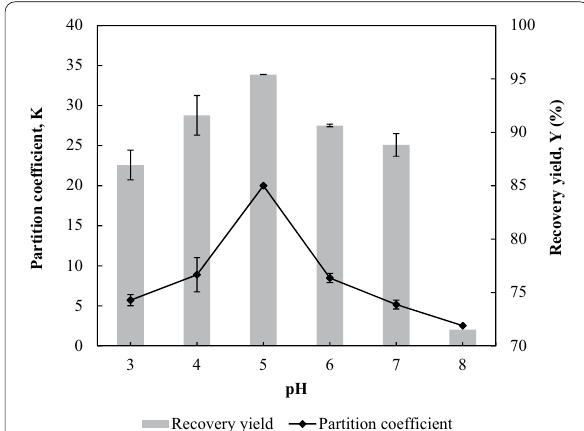
Fig. 4 Effect of pH on the partition efficiency of BSA. The pH of the 35% (w/w) 1‑propanol/22% (w/w) maltose ABS with 10% (w/w) BSA was varied between pH 3.0 and pH 8.0 to investigate the effect of pH on the K and Y of BSA. The results are expressed as mean deviation of triplicate